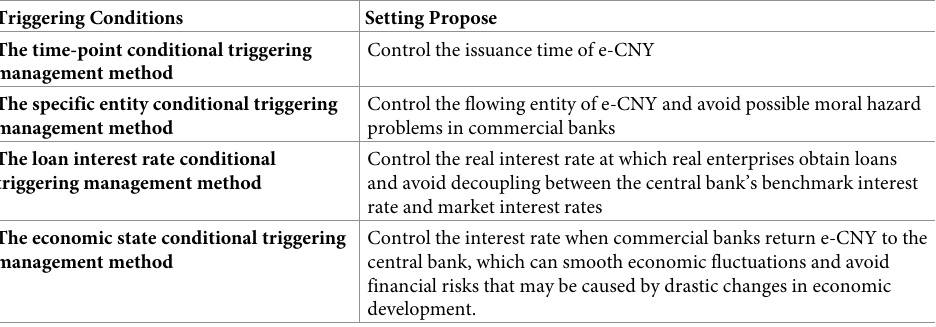
Table 1. E-CNY’s forward-looking condition triggering